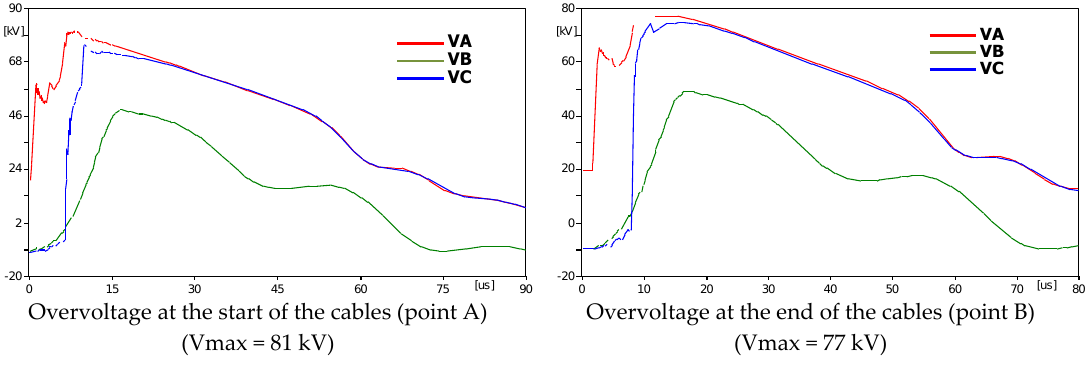
Figure 44. A 300 m underground cable.